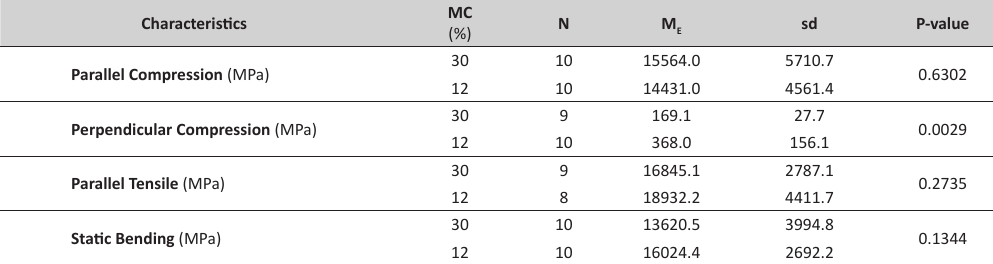
TAble 4. Eucalyptus maidenii wood modulus of elasticity